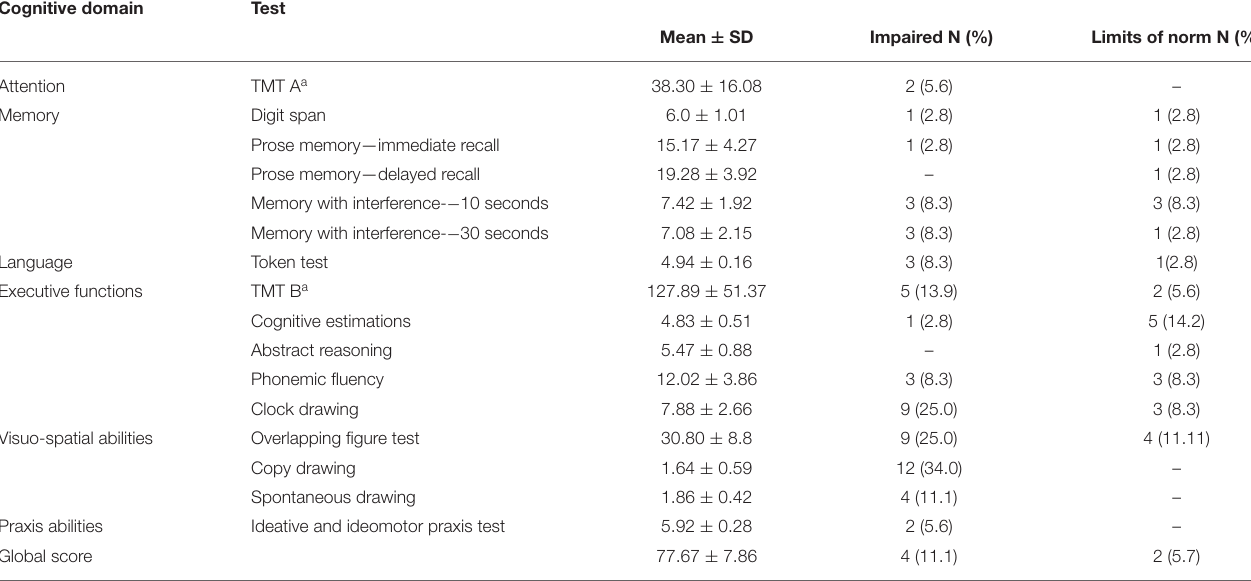
TABLE 2 | Cognitive functions in early detoxified AUD subjects ( N = 36).